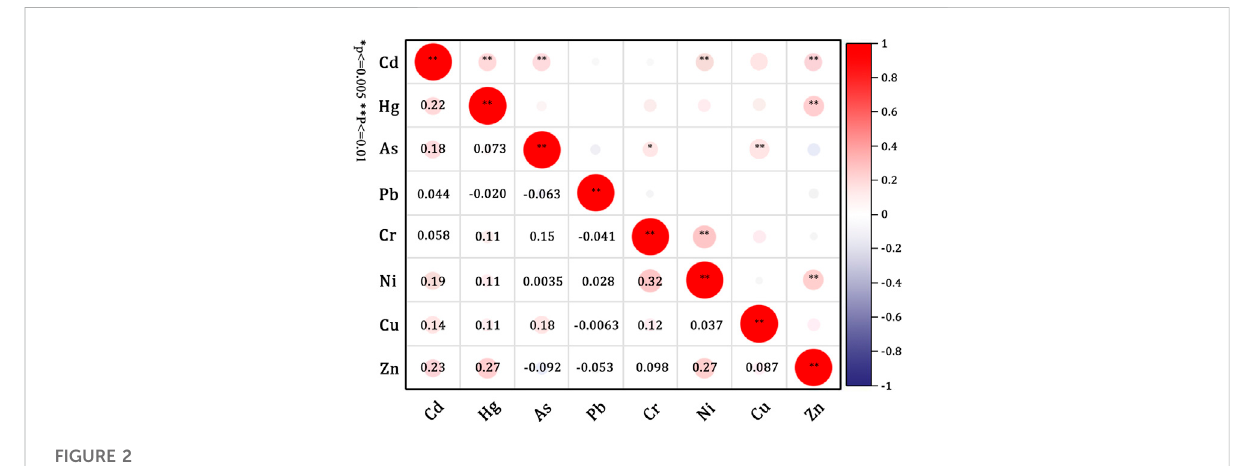
FIGURE 2 Correlation analysis of heavy metal content in rice.